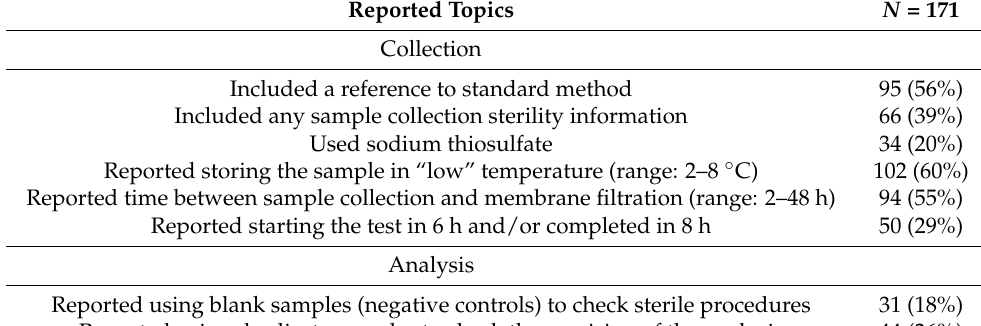
Table 1. Literature review results on reporting the sample collection, analysis, and processing. BDL, below detection limit; ADL, above detection limit.